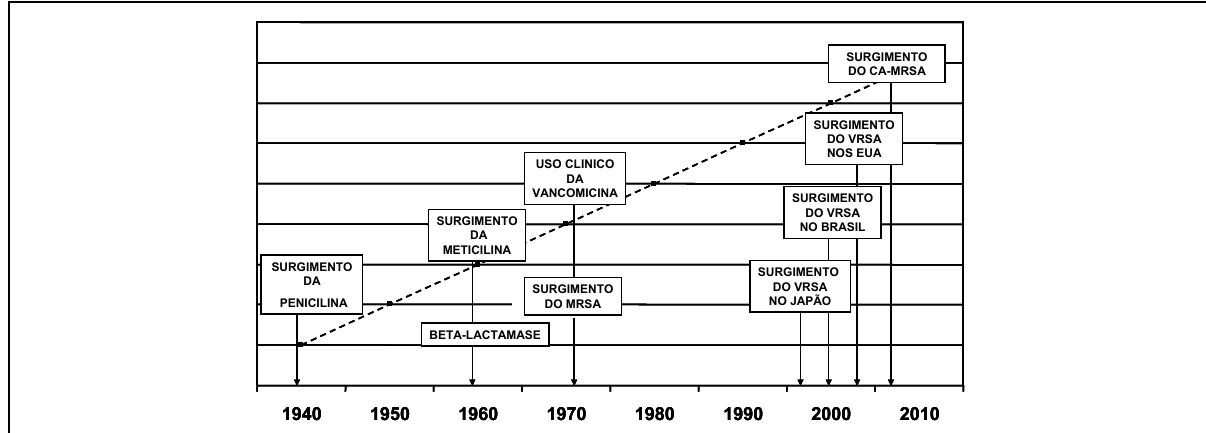
Figura 2 – Surgimento de alguns antibióticos e cepas resistentes do S. aureus nos séculos XX e